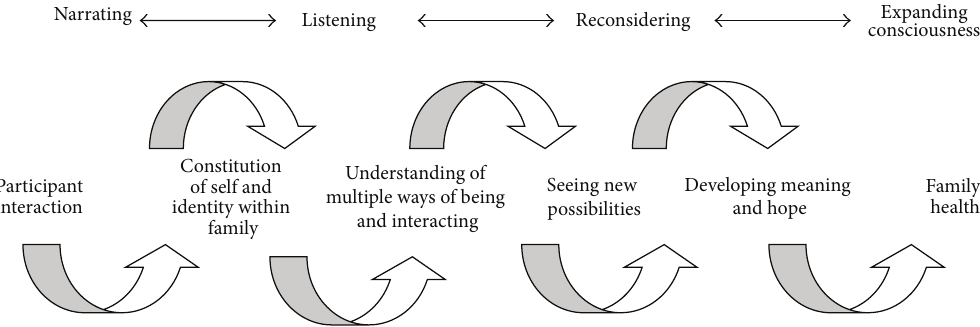
Figure 1: Family Health Conversations illustrated as a spiral movement towards family